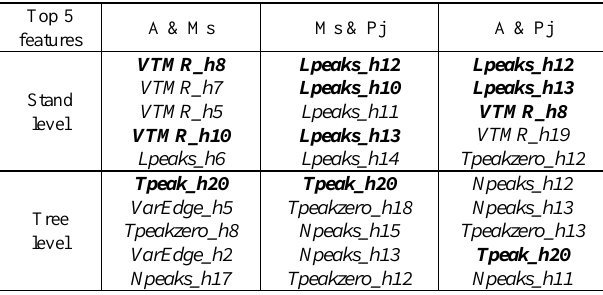
Table 2. The best five features selected by scalar feature selection method for each separation group for both of the stand and individual tree level. A: aspen;Ms: sugar maple;Pj: jack